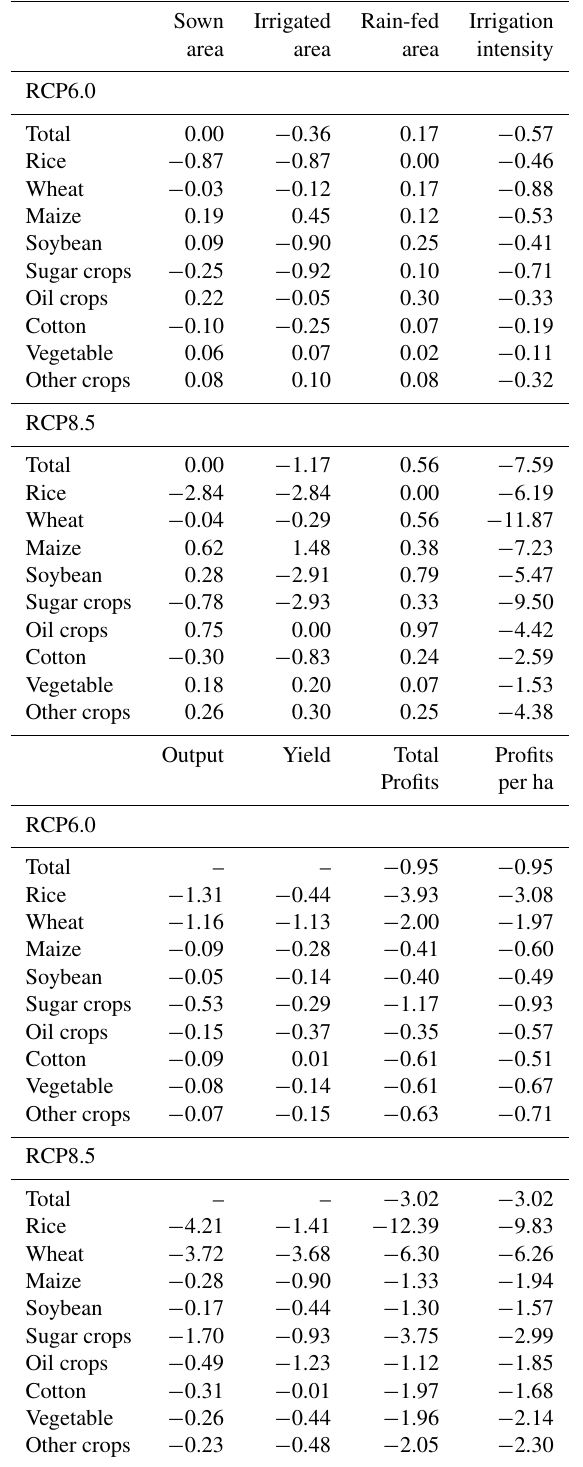
Table 5. Percent changes of key factors in the SRB River Basin under climate in 2030